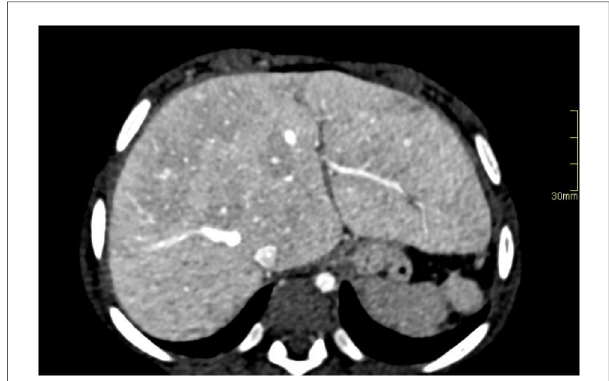
FIGURE 4 Hypoplastic left heart syndrome with Fontan circulation in a 4-year-old girl with failing Fontan. Abdominal CT with i.v. contrast, portal venous phase, in an axial plane reveals hepatomegaly with round hepatic borders and perisinusoidal